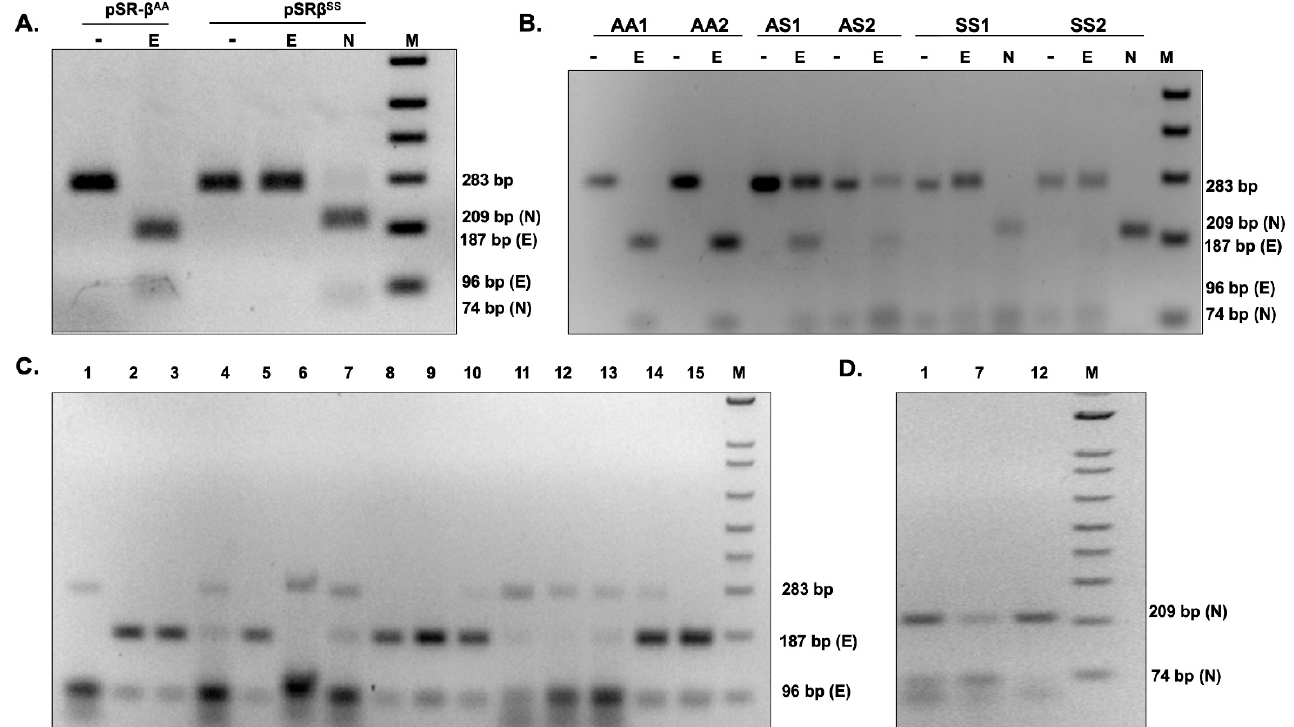
Figure 4. iDAR using recombinant plasmids and patient buccal swabs: ( A ) iDAR using Eco81I (E) digestion of recombinant plasmids pSR- β AA and pSR- β SS with internal digestion control of NcoI (N). ( B ) Eco81I screening in individuals with known genotypes AA, AS S , and SS S with internal digestion control of NcoI (N) for n = 2. ( C ) iDAR of buccal swabs of unknown genotype; n = 15. ( D ) iDAR with internal control digestion with Nco1(N) of SS samples.